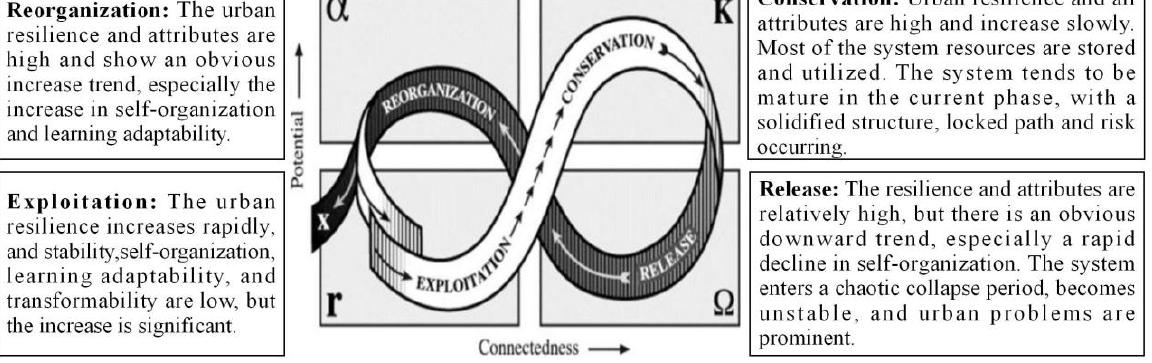
Figure 1. Evolutionary urban resilience model (Refer to the adaptive cycle model of Holling and Gunderson